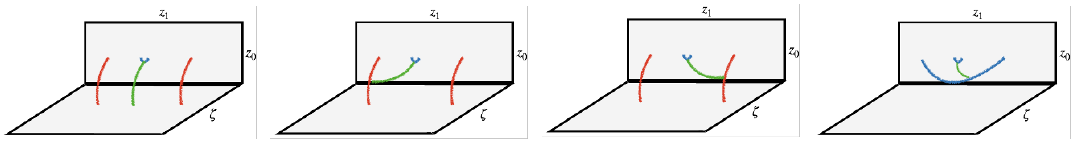
Figure 13 . The four possible phases (I-IV left to right) of E W (green) for adjacent intervals. We exaggerate the distance between the intervals to emphasize that we need to treat the cuto(cid:11)